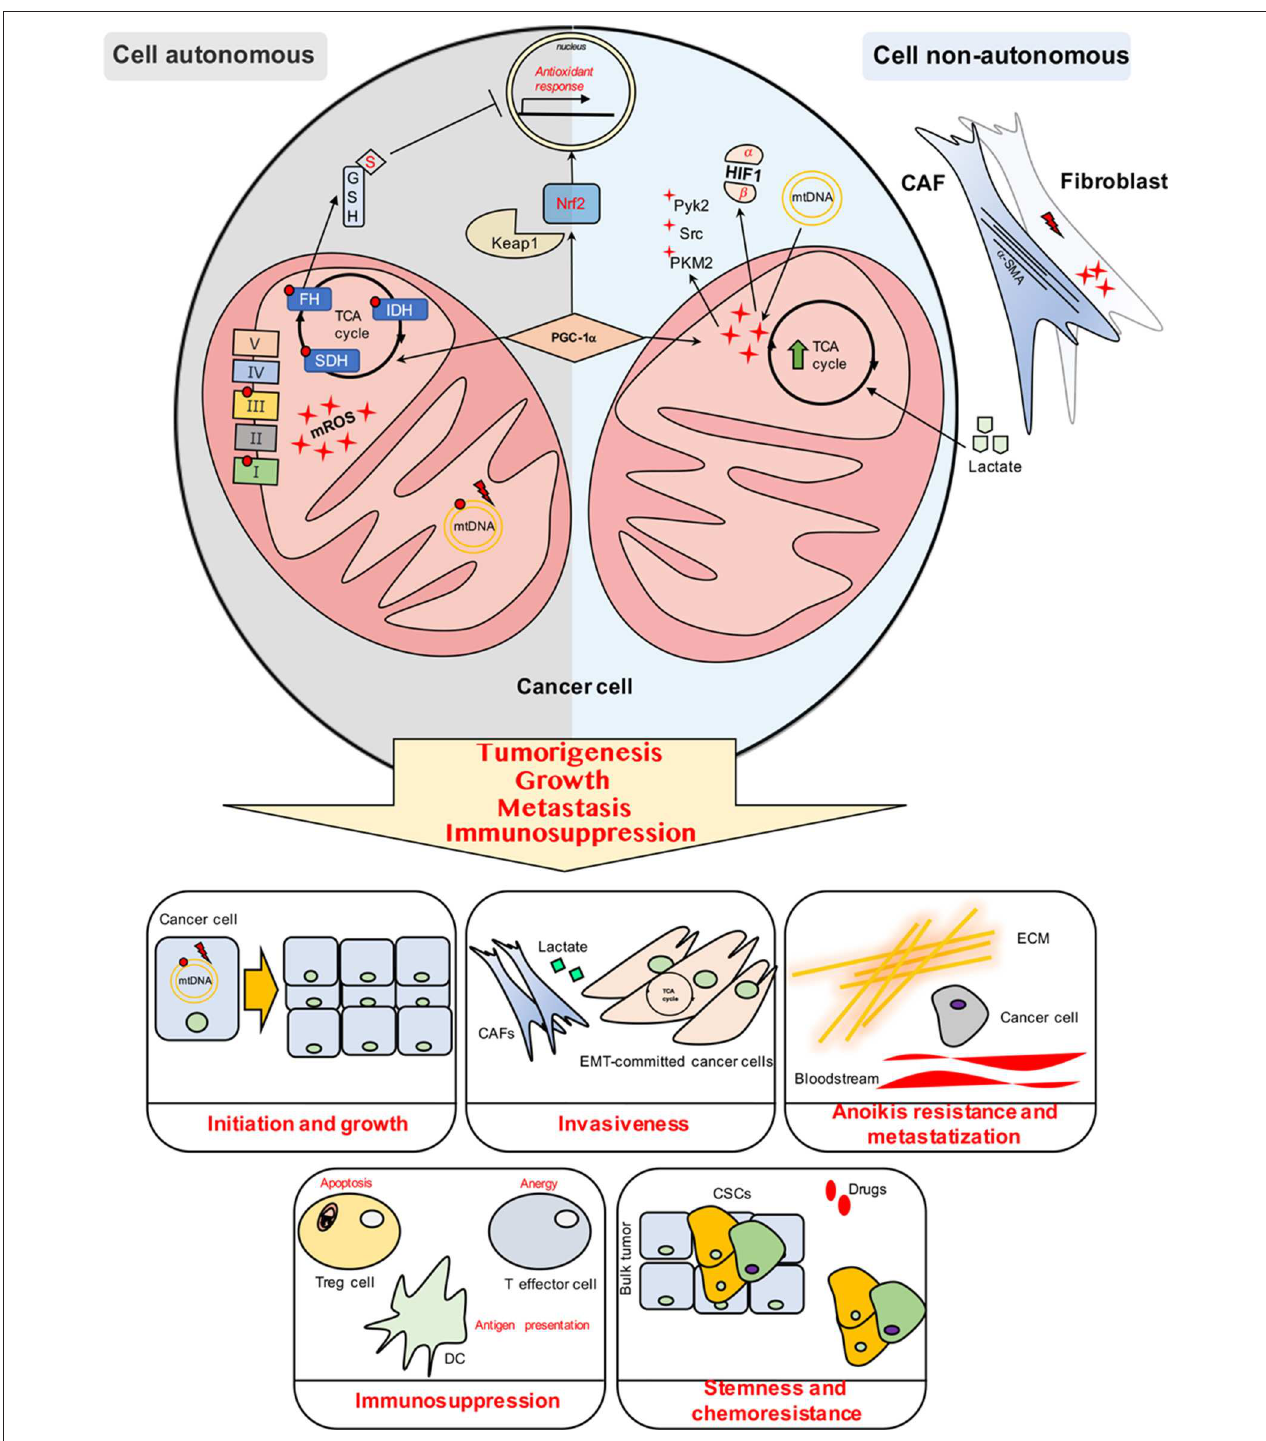
FIGURE 1 | Cell autonomous and cell non-autonomous mechanisms impact on the mitochondrial ROS (mROS) production and management in cancer cells.